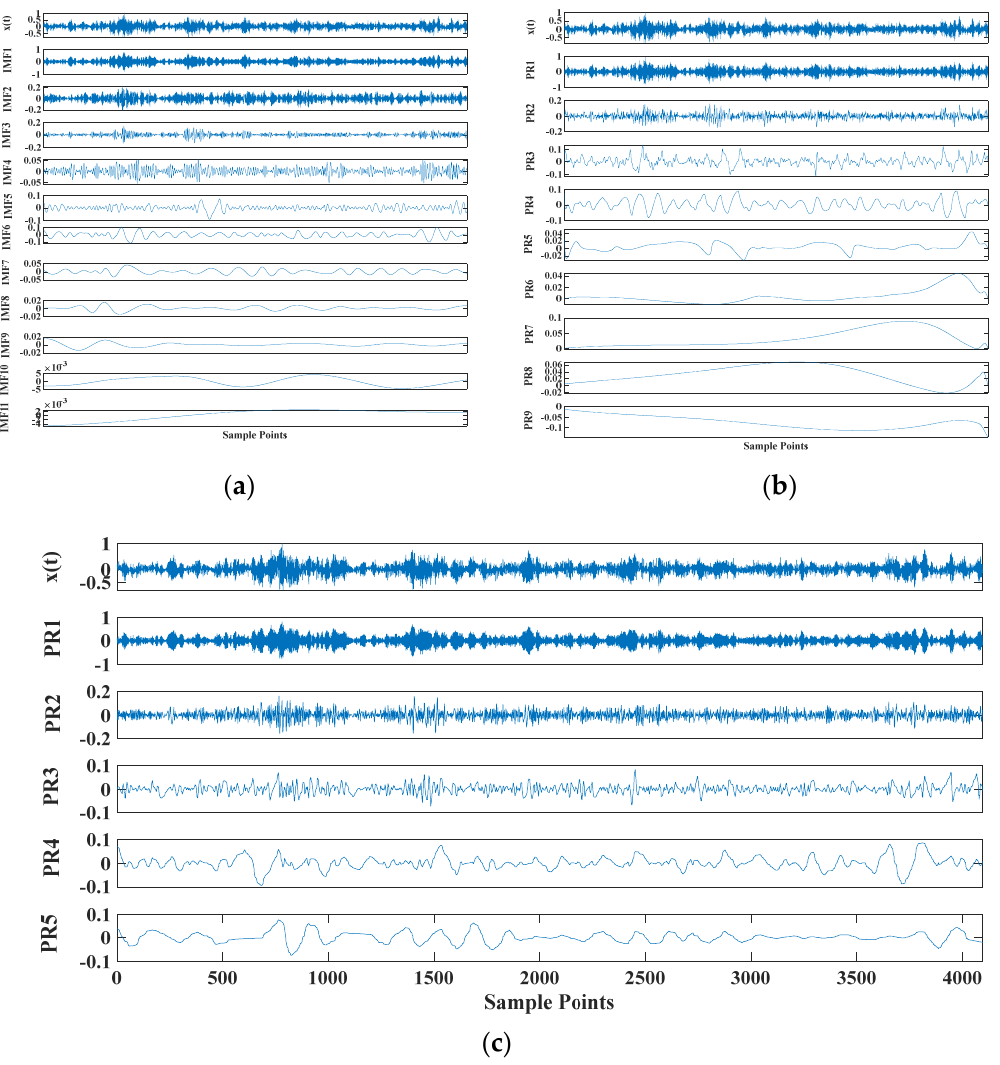
Table 6. The obtained parameter values show that the method that is proposed in this paper has substantial advantages over the other two methods.